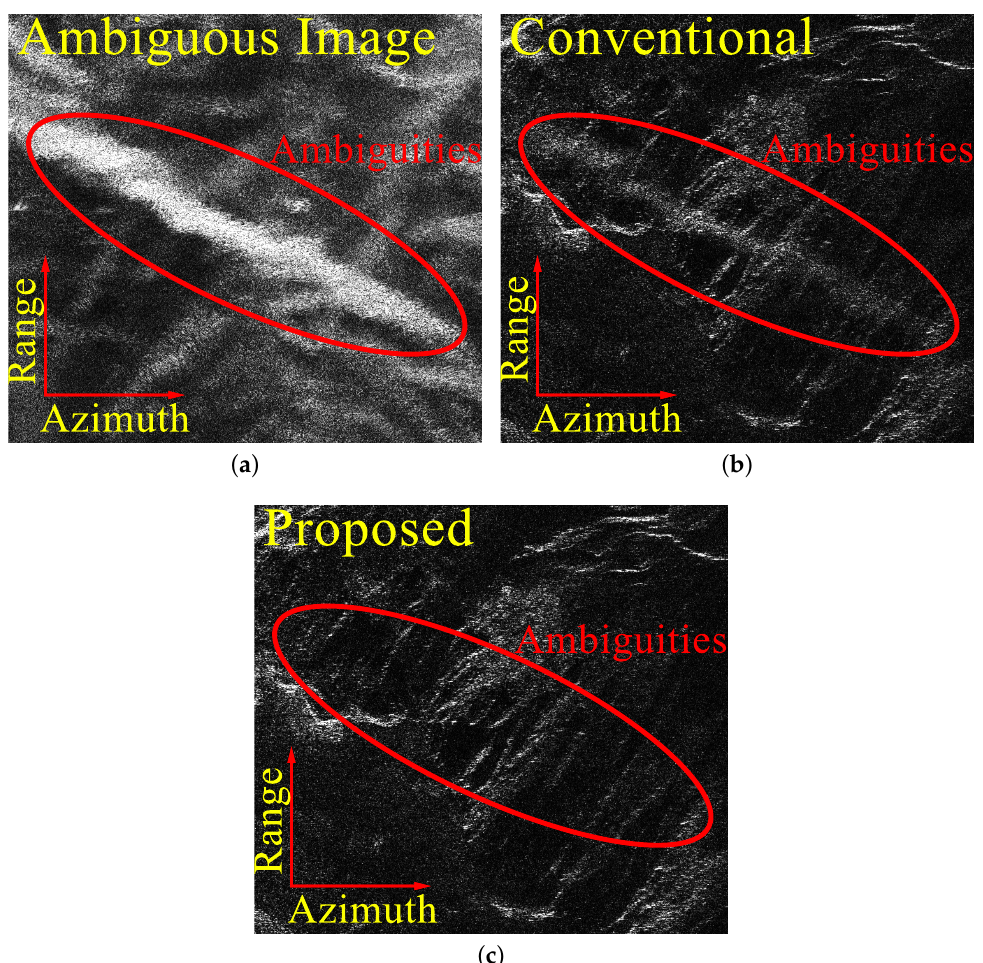
Figure 14. Local zooming of imaging results of the GF-3 dual-channel mode of different calibration methods. ( a ) Without channel errors calibration. ( b ) Using the time-domain correlation method. ( c ) Using the proposed